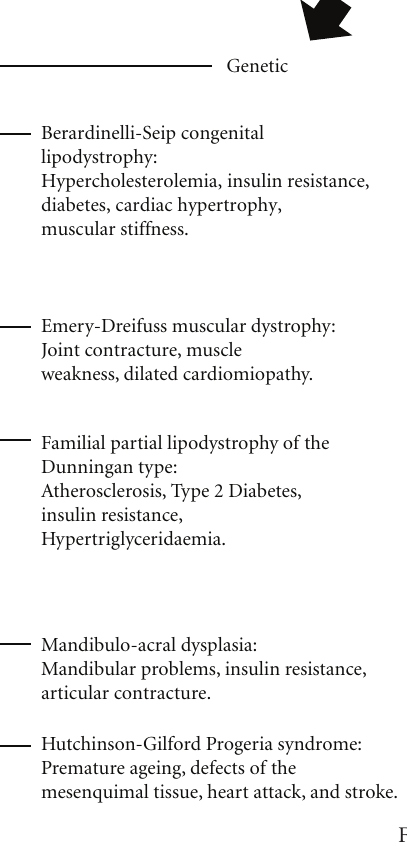
Figure 1: Lipodistrophic syndromes.